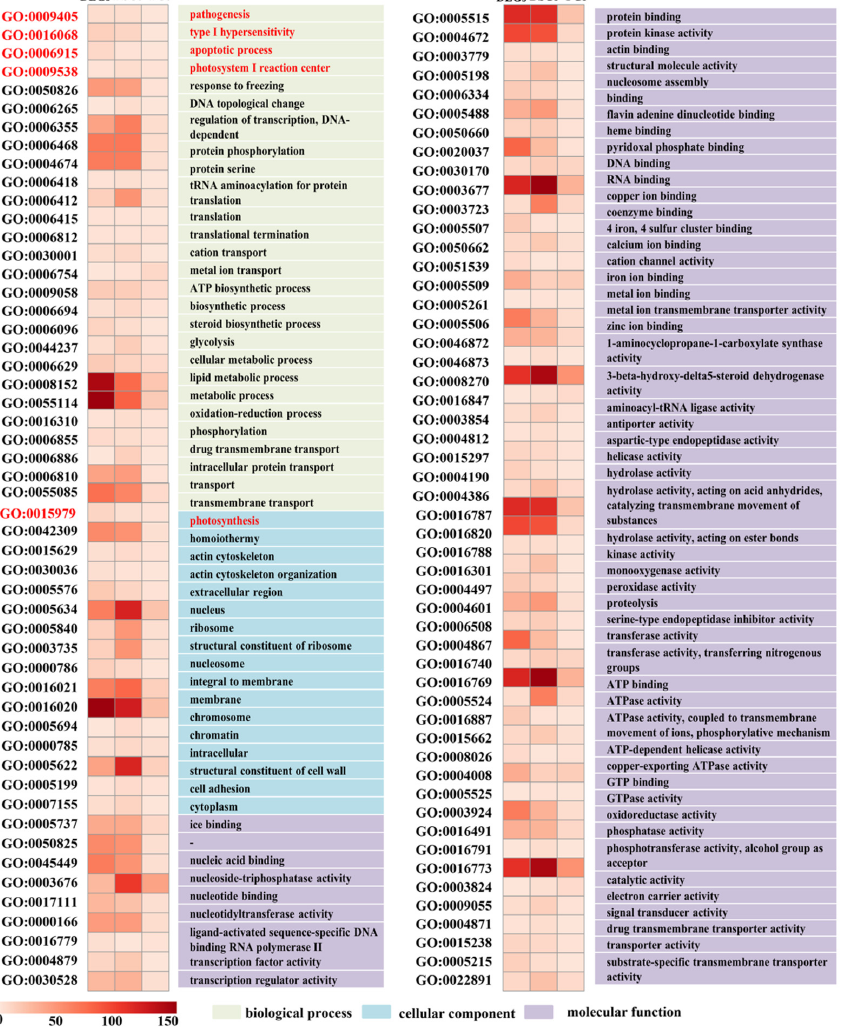
Figure 5. Analysis of functional enrichment of DSG&DEG&FG-overlapped genes Color scale indi- cates enrichment folds of various GO terms. Only significantly enriched terms ( p < 0.05, enrichment fold ≥ 1.5) are displayed. The red colored words are related to the regulation pathway of maize rough dwarf disease resistance.